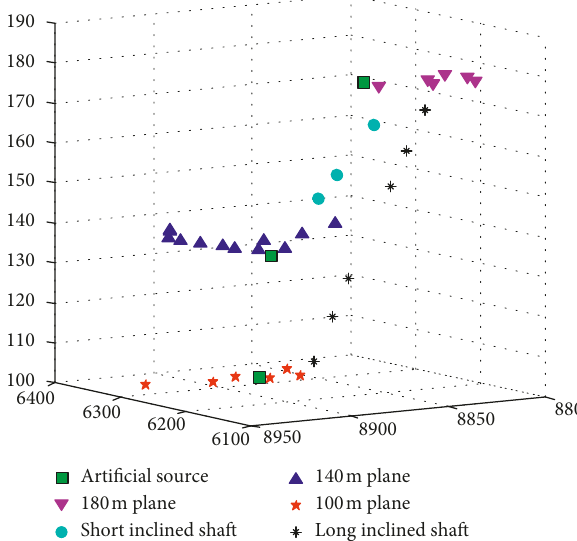
Figure 5: Sensor and artificial source space